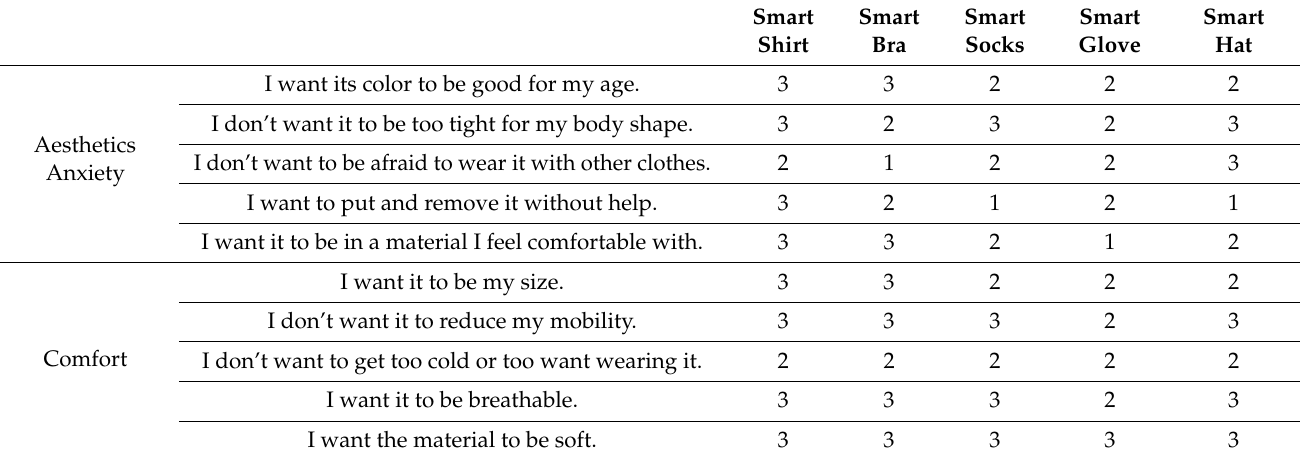
Table 1. Acceptance evaluation matrix for smart